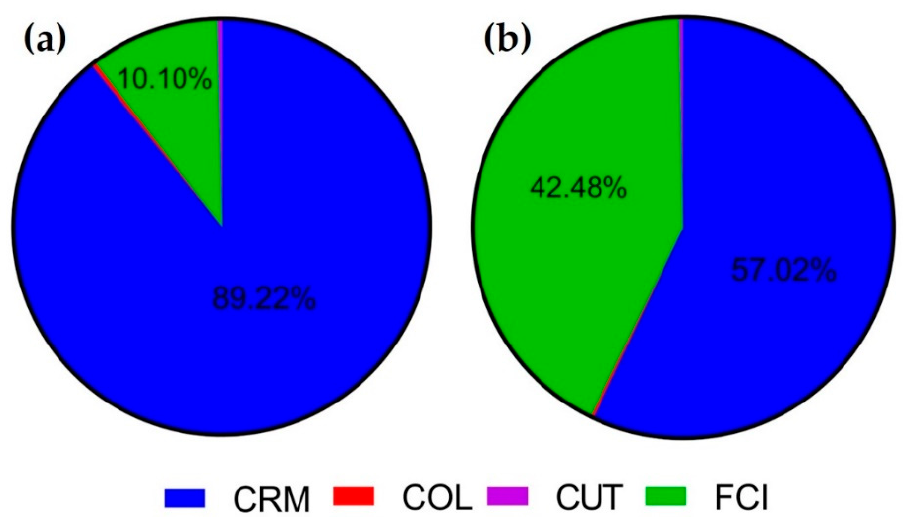
Figure 4. Contribution of each component (CRM, CUT, COL, and FCI) on the COM for bioactive compounds of M. flexuosa obtained by ( a ) Conventional solvent extraction (CSE) and ( b ) Supercritical fluid and conventional solvent extraction (SFE+CSE).